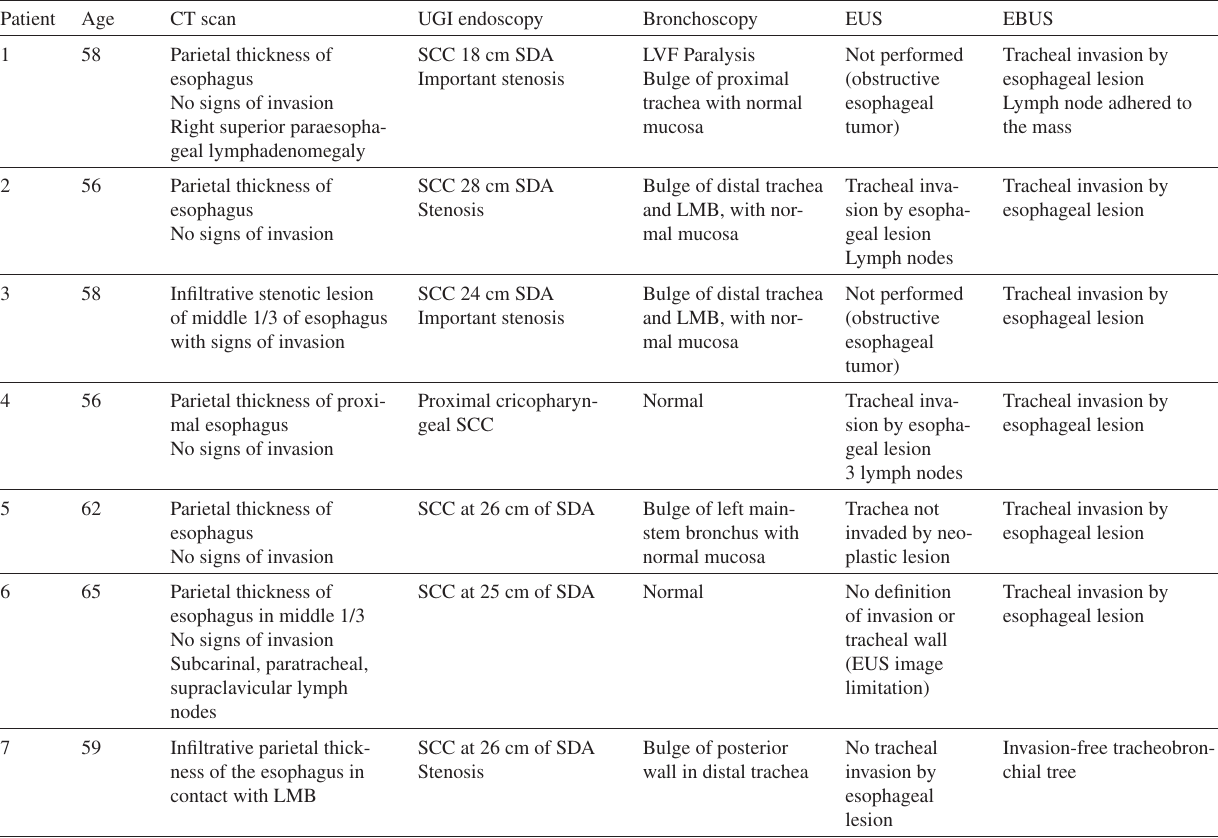
Table 1 - Characteristics of patients studied and results of the tests